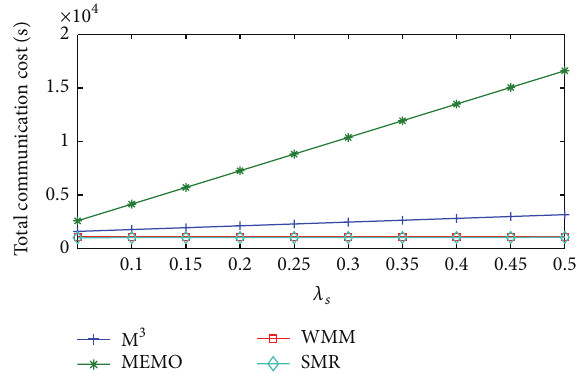
Figure 12: Total communication cost/sec versus 𝜆 𝑠 .